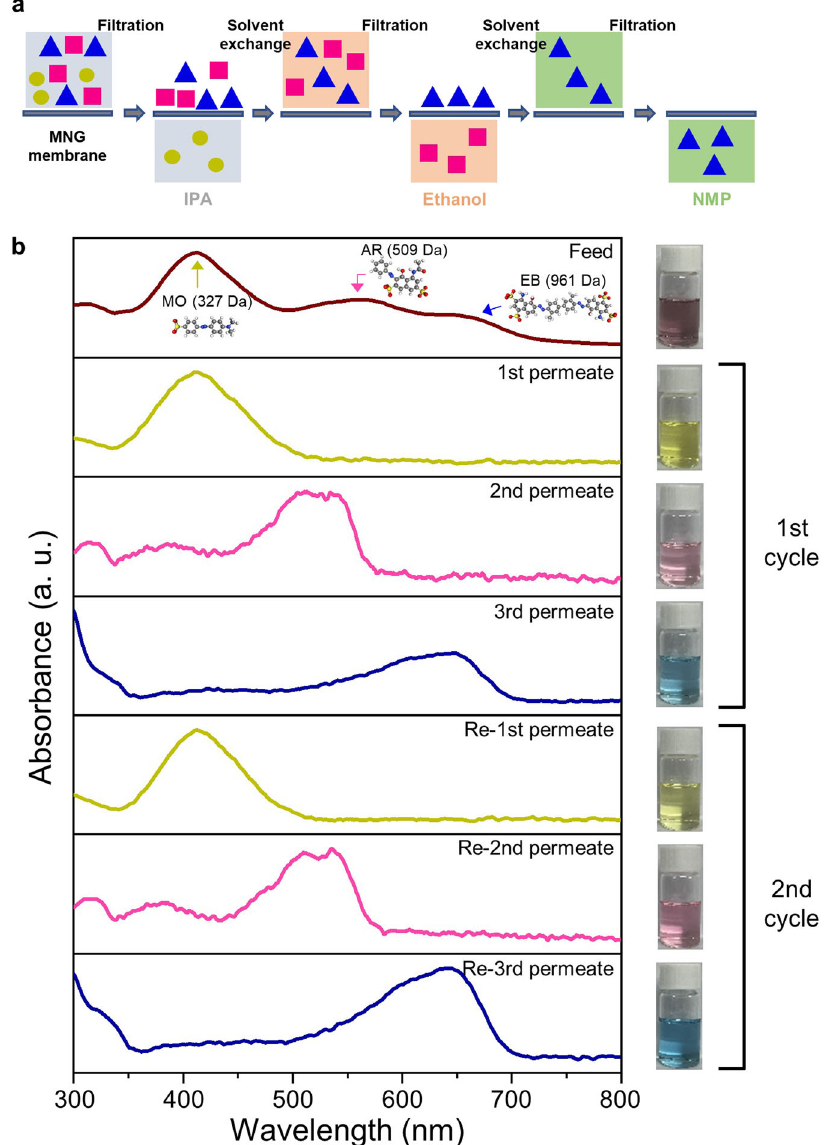
Fig. 7 | Switching MNG membrane performance for ternary dye mixture separation under dead-end fi ltration. a Schematic image of ternary dye